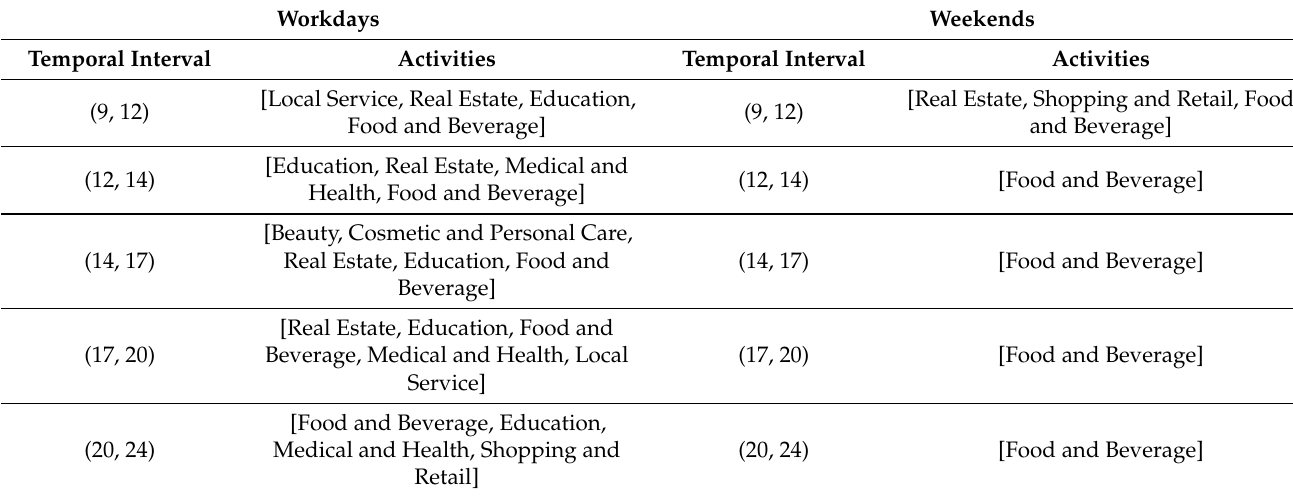
Table 6. Example of a user’s predicted